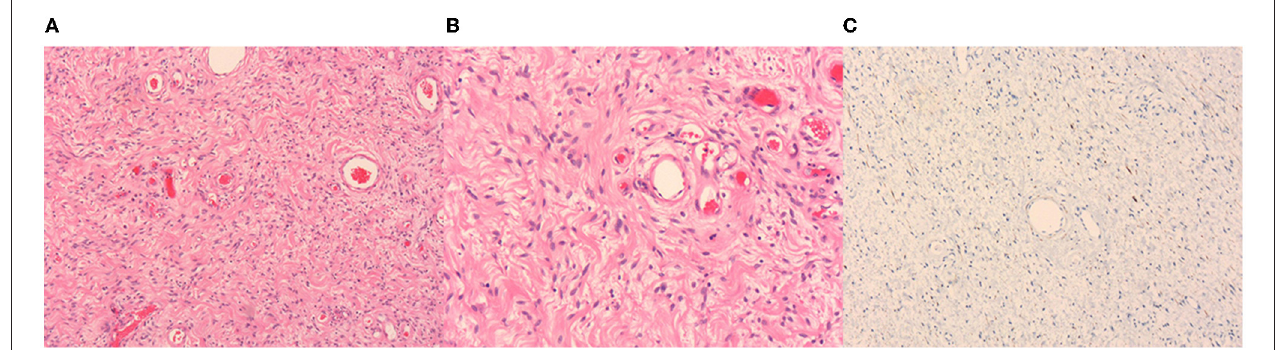
FIGURE 2 | Hematoxylin-eosin (HE) staining and immunohistochemistry of the tumor. Thin-walled blood vessels surrounded by several spindle cells can be seen in the images (A,B) . Image A and Image B represent 50 × and 100 × , respectively. The desmin is positive in immunohistochemistry (C)